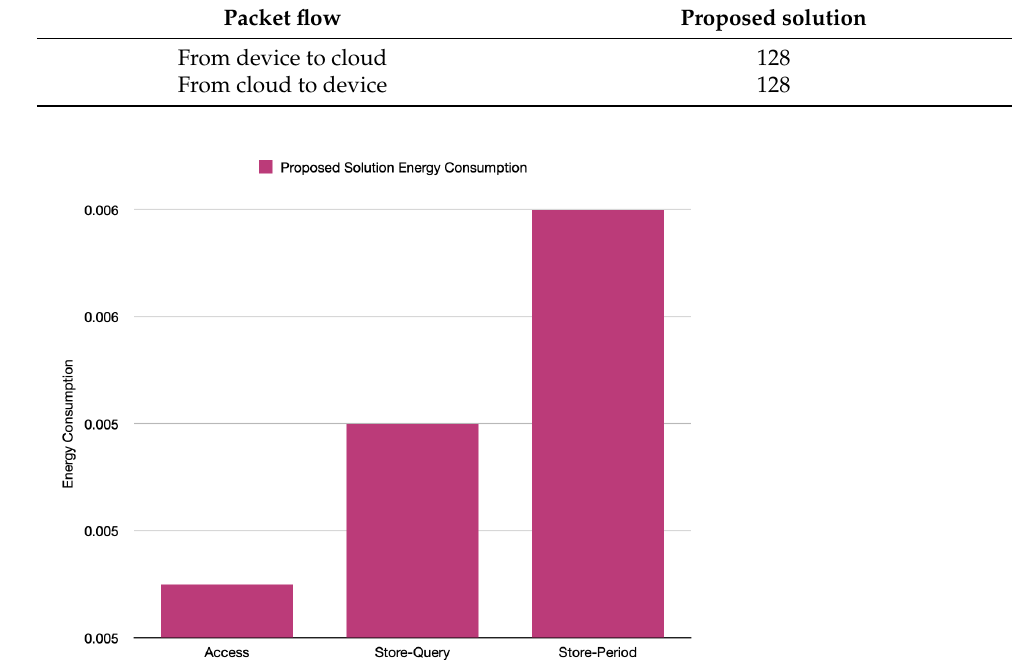
Table 4. Packet overhead (bytes) of healthcare.